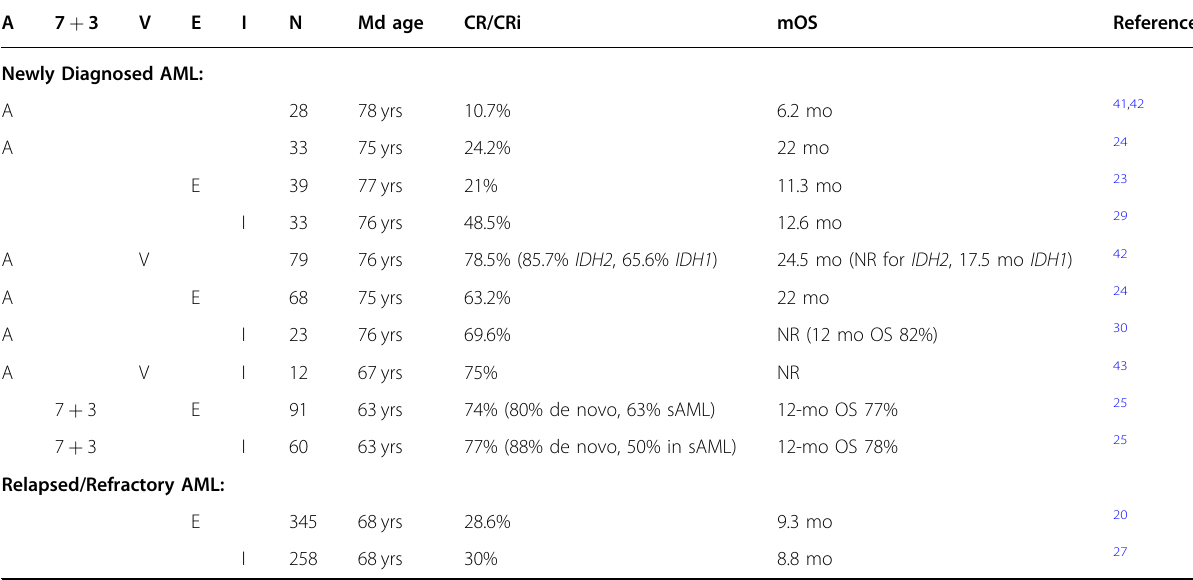
Table 1 Clinical activity of IDH inhibitors as single agents or in